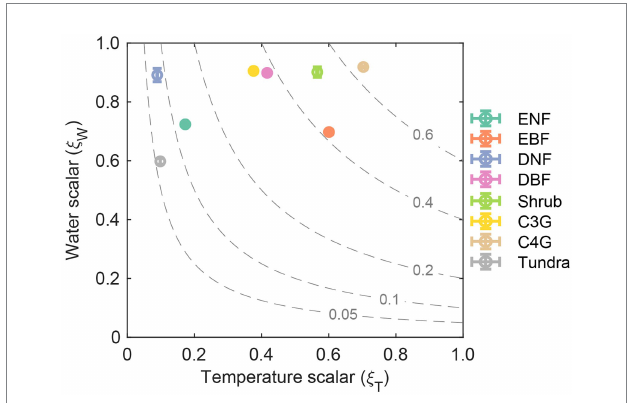
FIGURE 5 Determining of the environmental scalars ( ξ ) by temperature scalars ( T ξ ) and water scalars ( W ξ ) among biomes. The dashed line show the constant value of environment scalars. Abbreviations of biomes are given in Figure 3.